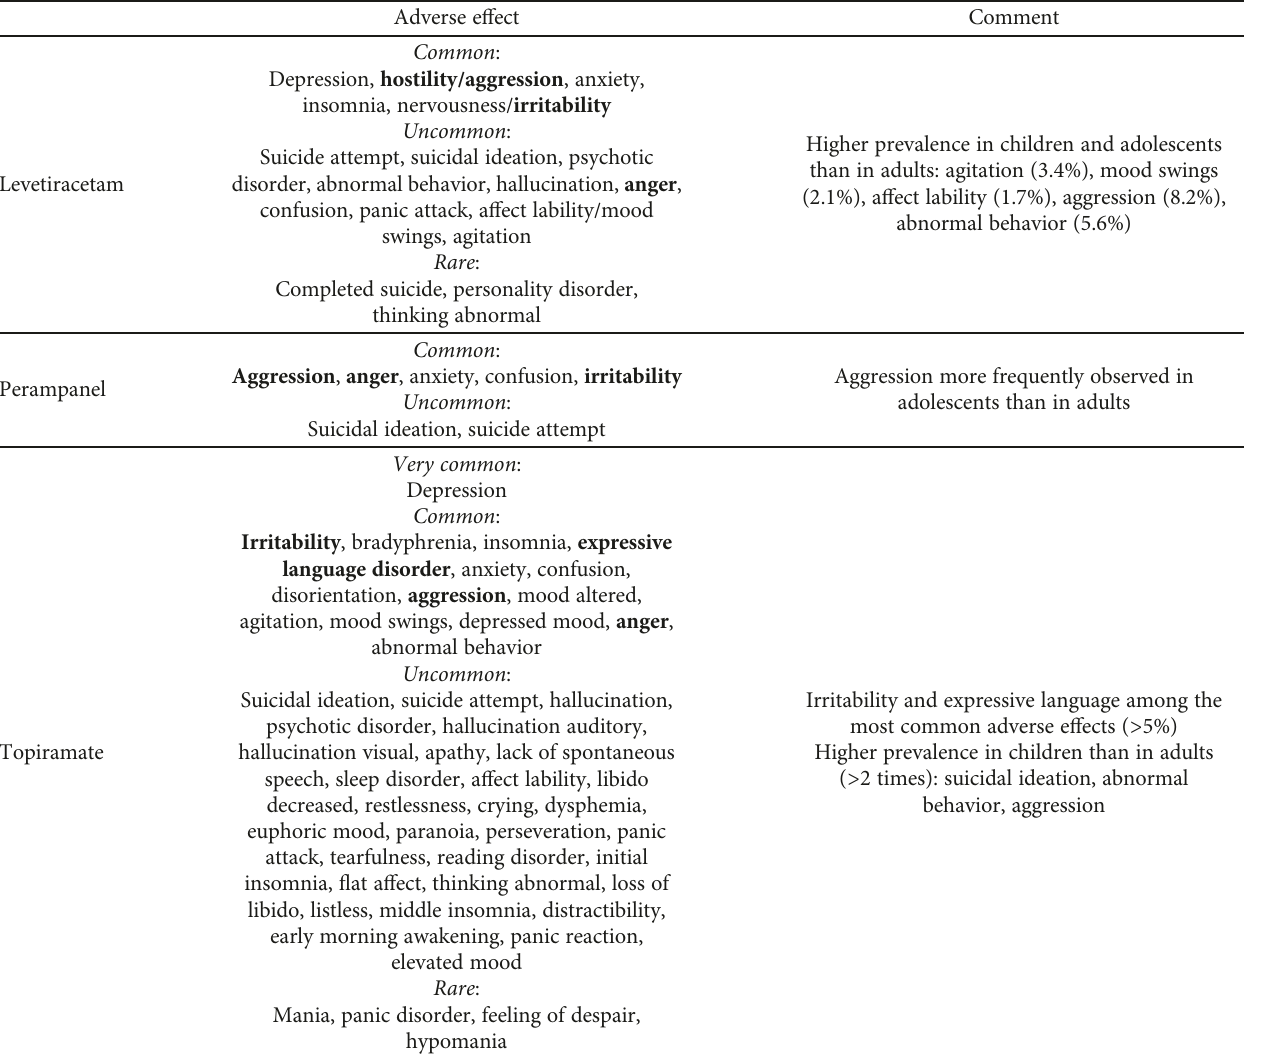
Table 1: Frequencies ∗ of various psychiatric and behavioral adverse e ff ects of levetiracetam, perampanel, and topiramate according to their European SPCs [24 –